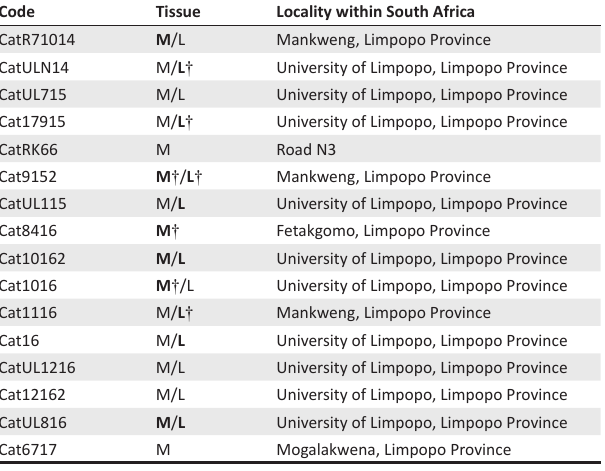
TABLE 1: Samples screened in this study.